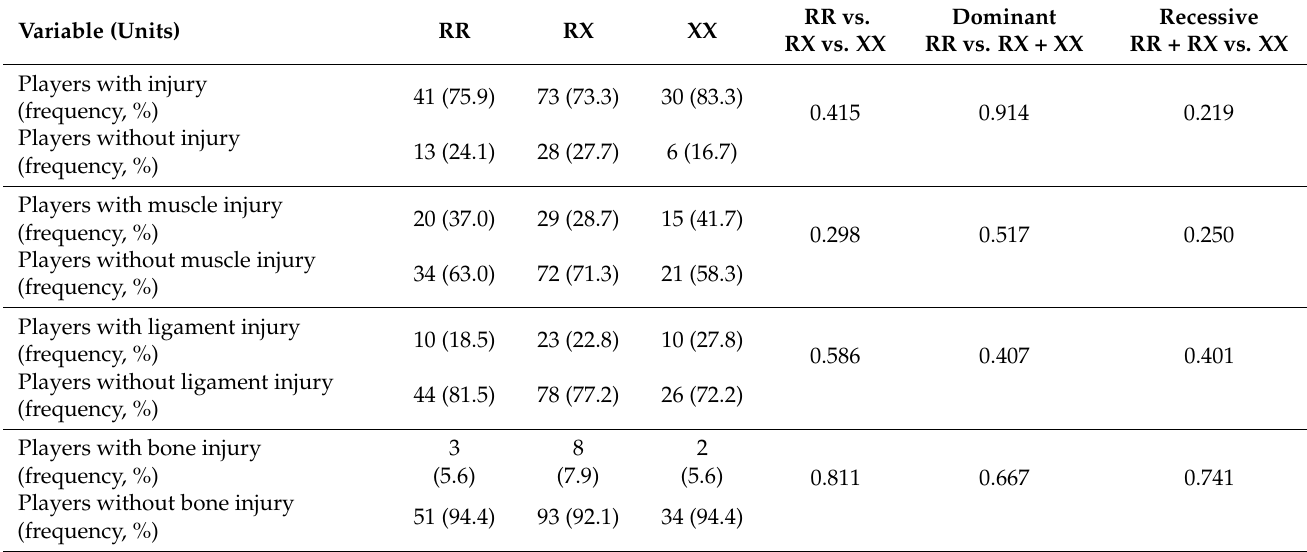
Table 3. Distribution of women football players of the first division of Spanish football with/without an injury according to their ACTN3 R577X